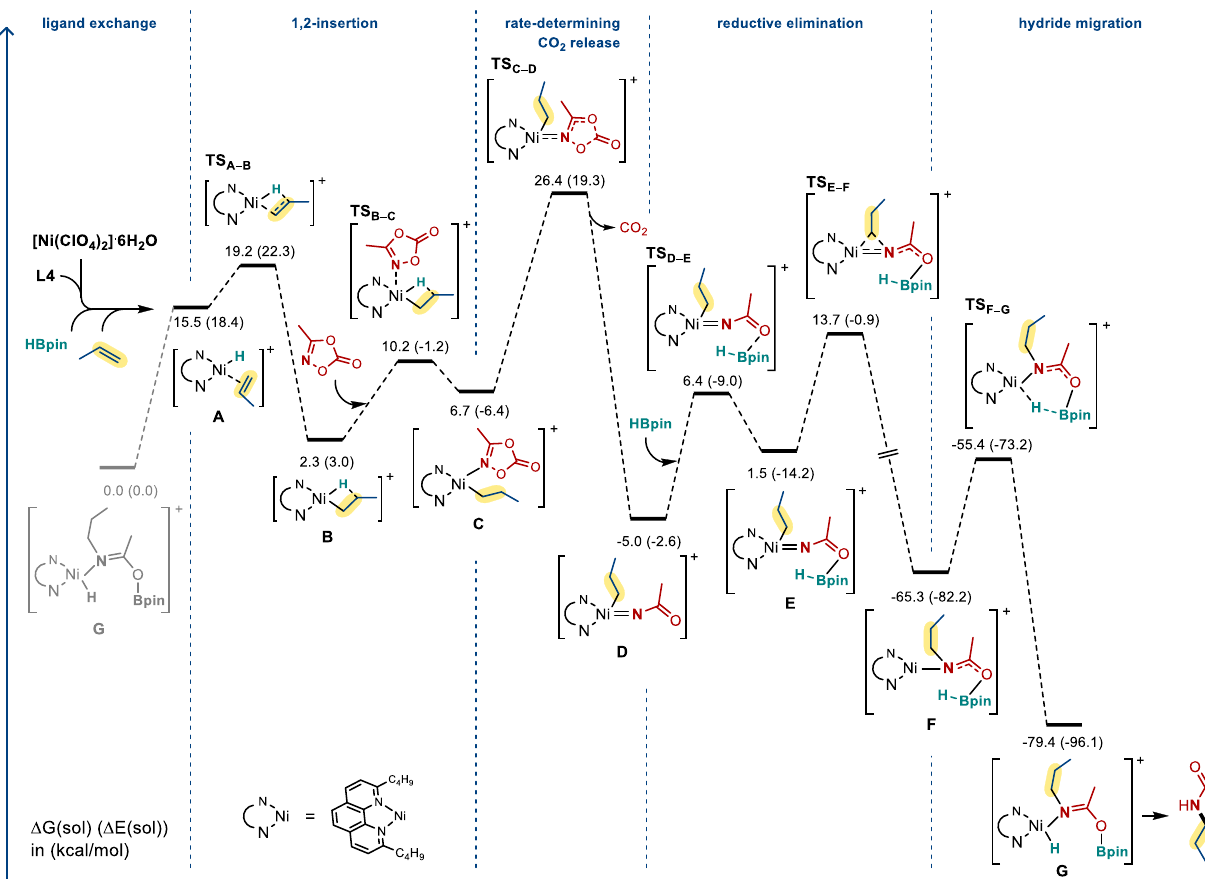
Fig. 8 Gibbs free energy pro fi le calculated for the Ni-catalyzed reaction of propene with 3-methyl-1,4,2-dioxazol-5-one. The relative Gibbs energies and electronic energies (in parentheses) are given in kcal mol − 1